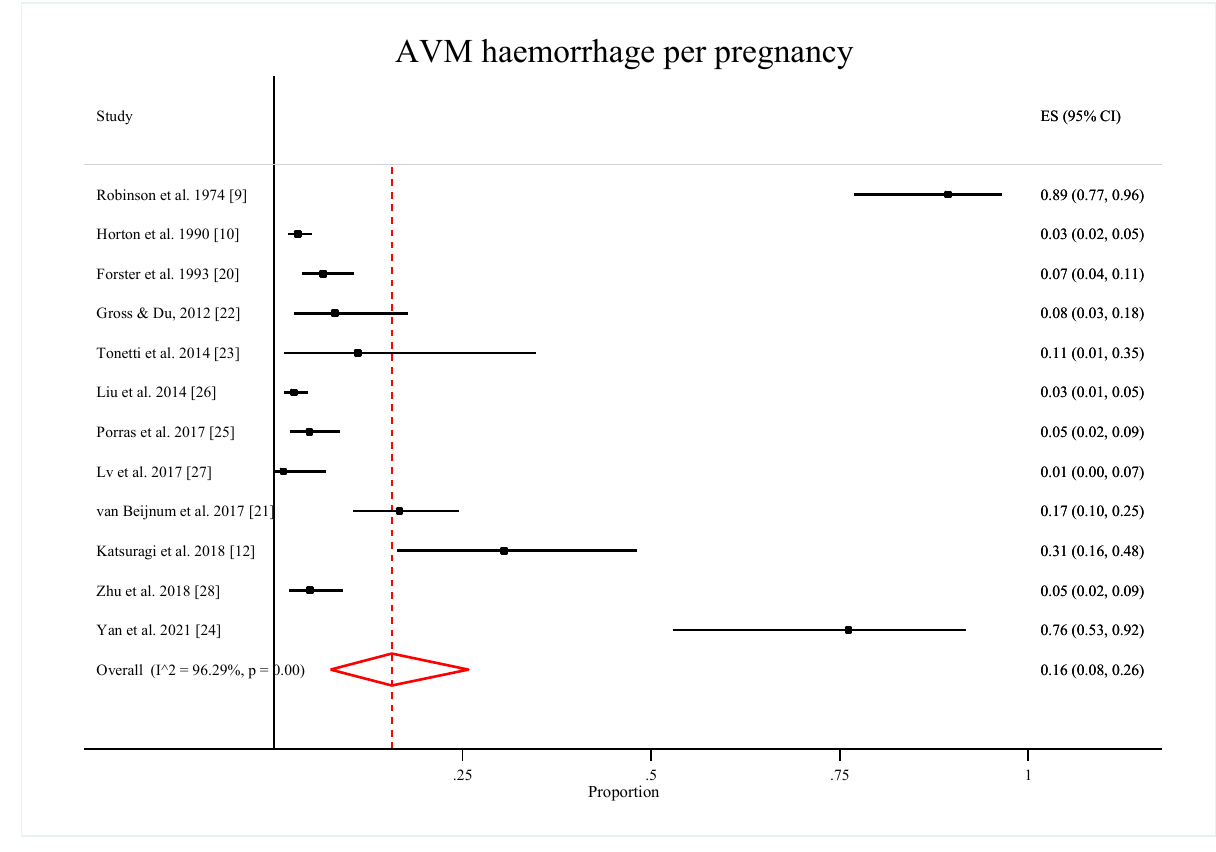
Figure 2. Forest plot of the pooled proportion of AVM hemorrhage per pregnancy by double arcsine transformation method [9,10,12,20–28].